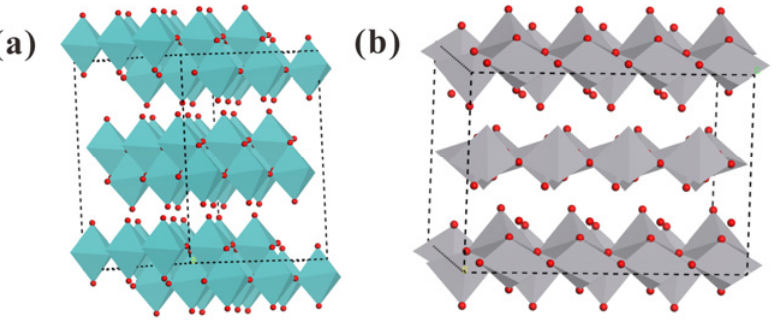
Fig. 15 Schematic diagrams of crystal structures of (a) MoO 3 and (b) V 2 O 5 .